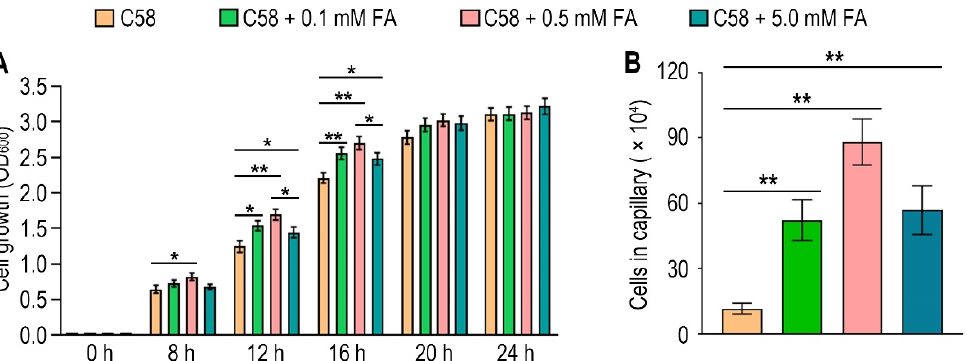
Figure 4. Formic acid can promote the growth of A. fabrum C58 and act as its chemoattractant. ( A ) Formic acid promoted the growth of A. fabrum C58. To the initial bacterial culture with OD 600 = 0.03, 0, 0.1 mM, 0.5 mM or 5 mM formic acid were added. OD 600 of each culture was measured after incubation for 8, 12, 16, 20 and 24 h. ( B ) Capillary assay of A. fabrum C58 for formic acid. In the capillary assay, 0, 0.1 mM, 0.5 mM and 5 mM formic acid were applied. Data are the means of three biological replicates with the SD in ( A ) and ten biological replicates with the SD in ( B ). Significant difference ( p < 0.05) is indicated by * and significant difference ( p < 0.01) is indicated by ** in ( A , B ).